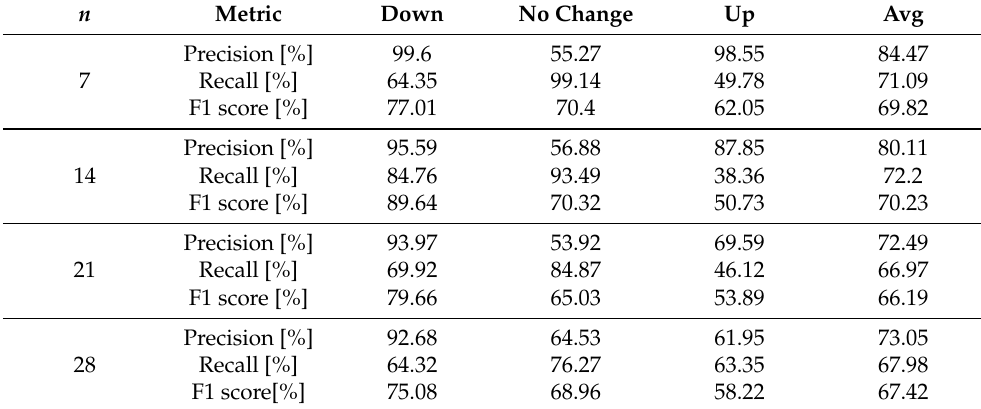
Table 6. Classification results [%] for data from tour operator T2 and series length